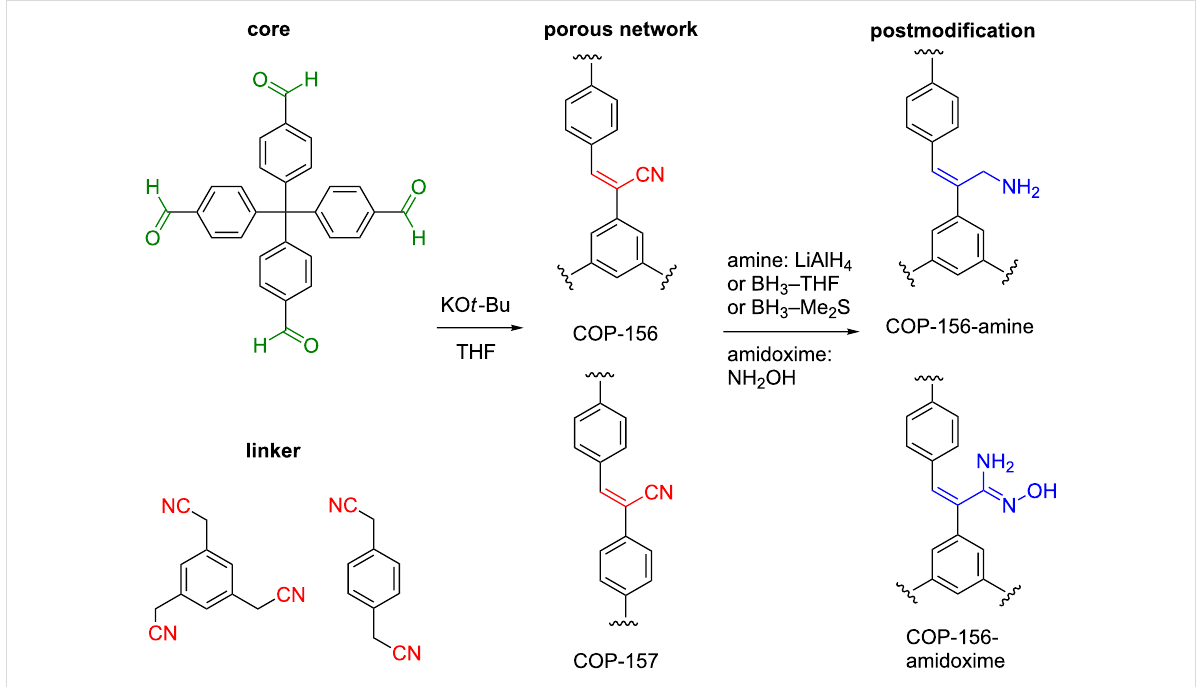
Scheme 1: Synthesis route for COP-156 and COP-157, and the post-modification of